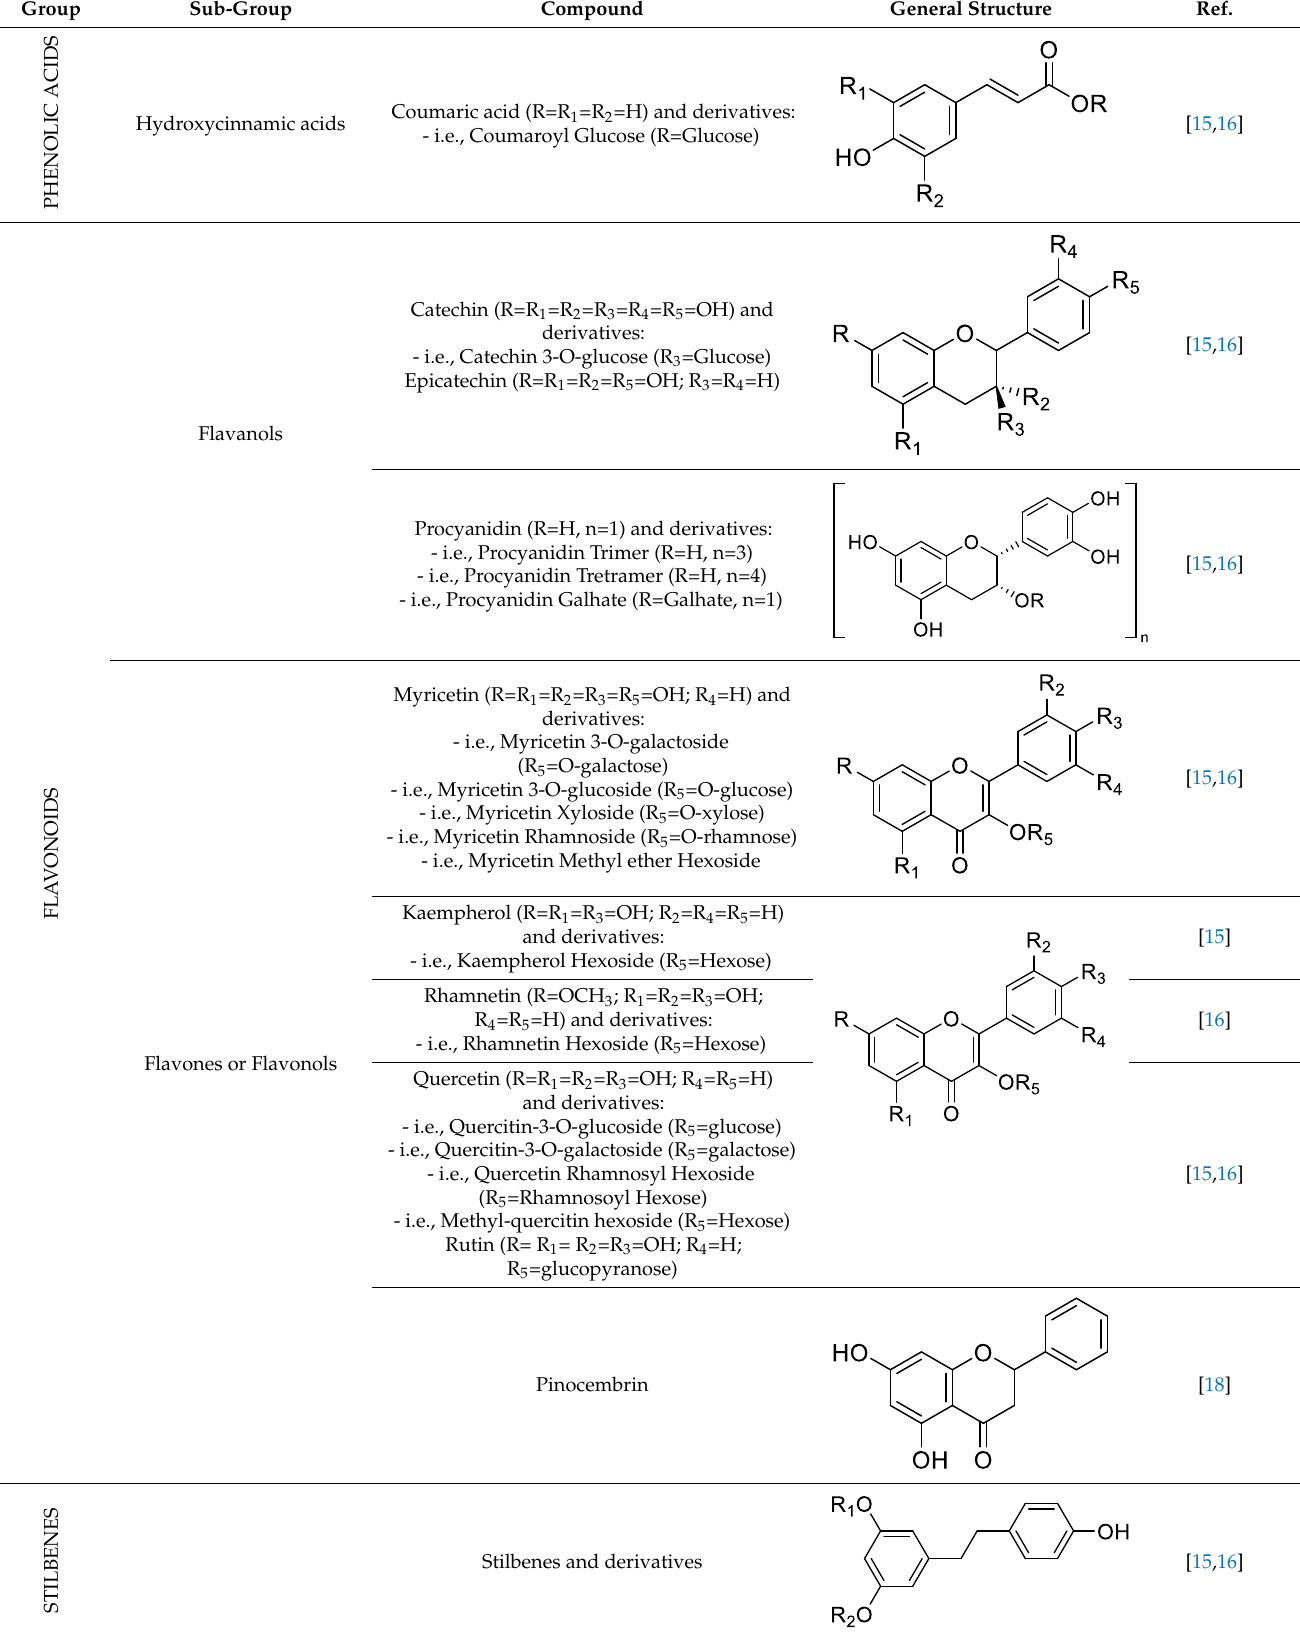
Figure 2. Structure of identified chalcones in C. album : ( A ) R = OH, 2′ , 4′ -dihydroxydihydrochalcone, R = OCH 3 , 2′ -methoxy- 4′ -hydroxydihydrochalcone; ( B ) 2′ , 4′ -dihydroxychalcone. Both the berries and leaves from C. album revealed interesting bioactive properties, which are summarized in Figure 3. Scientific information regarding C. album ’s bioactive activities is very scarce and is mostly focused on the beneficial healthy properties of its berries. C. album berries were described to have antimicrobial [11] and antioxidant activi- ties [7,11,14,15]. Moreover, this antioxidant activity seems to be increased after simulated digestion [13] and can protect against oxidative stress (yeast: [13]). C. album berries have also been described as having cytotoxic effects in Caco-2 cells when the concentration of the extract exceeds 8% [14]. There is also evidence that these berries are able to inhibit lipid peroxidation and acetylcholinesterase activation [11]. The bioactivity of C. album leaves has been studied regarding its cytotoxicity in yeast [15,20]; colon carcinoma cells (HT-29 cells: [17]), an effect that seems to be mediated through G2/M cell cycle arrest [18,21]; and apoptosis [18]. The cytotoxicity observed was reported to be triggered by the pro-oxidant activity of at least two different hydroxydihy- drochalcones found in these leaves [17]. In contrast, a study using an enriched fraction of polyphenols from C. album leaves claimed that this extract has promising cytoprotective effects, modulating key events in Parkinson’s disease pathogenesis. Some other reports also describe C. album leaves as having antioxidant effects